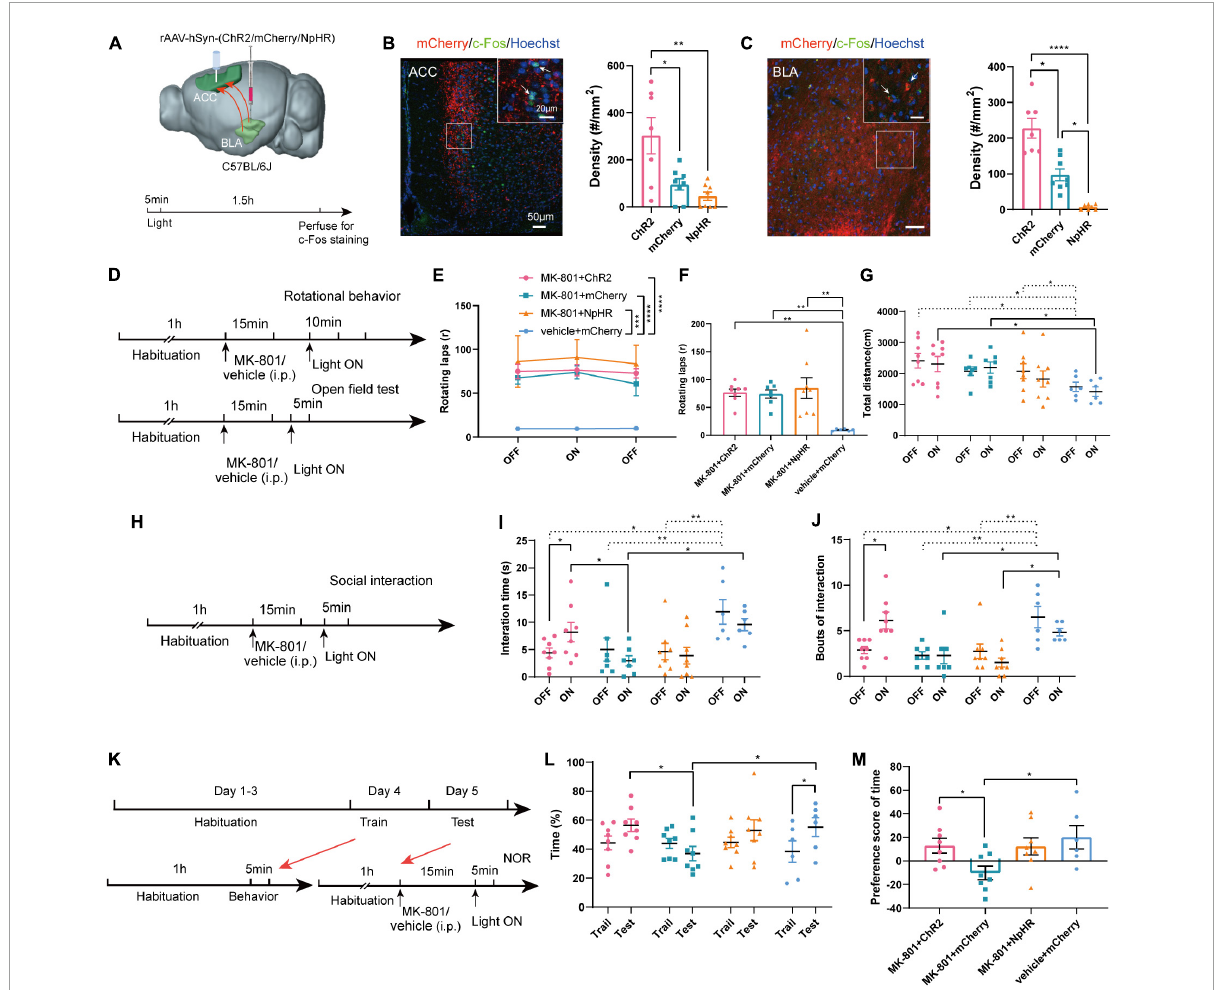
FIGURE5 Optogenetic modulation of basolateral amygdala-anterior cingulate cortex (BLA-ACC) projecting neurons affected social and cognitive deficits but not stereotypic rotational behavior in MK-801-treated mice. (A) Schematic of the mouse brain showing the bilateral injection of the rAAV2-hSyn-(ChR2/mCherry/NpHR)-WPRE-pA virus into the BLA and optical fibers implanted into the ACC of C57BL/6J mice. (B,C) The c-Fos-positive cells in the ACC [ (B) , Kruskal–Wallis H test, ChR2 n = 7 slices/4 mice, mCherry n = 8 slices/4 mice, NpHR n = 8 slices/4 mice] and BLA [ (C) , Kruskal–Wallis H test, ChR2 n = 7 slices/4 mice, mCherry n = 8 slices/4 mice, NpHR n = 7 slices/4 mice] after laser light on. (D) Timeline of optogenetic regulation of rotational behavior and OFT. (E–G) The results of the rotational behavior test [ (E) , Friedman’s M test; (F) , Kruskal–Wallis H test, MK-801 + ChR2 n = 8 mice, MK-801 + mCherry n = 7 mice, MK-801 + NpHR n = 8 mice, vehicle + mCherry n = 6 mice] and OFT [ (G) , One-factor ANOVA, MK-801 + ChR2 n = 8 mice, MK-801 + mCherry n = 7 mice, MK-801 + NpHR n = 8 mice, vehicle + mCherry n = 6 mice] after optogenetic regulation of BLA-ACC circuit. (H) Timeline of optogenetic regulation of social interaction behavior. (I,J) The results of the social interaction test (Kruskal–Wallis H test/One-factor ANOVA, MK-801 + ChR2 n = 8 mice, MK-801 + mCherry n = 7 mice, MK-801 + NpHR n = 8 mice, vehicle + mCherry n = 6 mice) after optogenetic regulation of BLA-ACC circuit. (K) Timeline of optogenetic regulation of NOR test. (L,M) The results of the percentage of time that mice spent in exploring the novel object [ (L) , One-factor ANOVA] and the preference scores of NOR test after optogenetic regulation of BLA-ACC circuit [ (M) , One-factor ANOVA, MK-801 + ChR2 n = 8 mice, MK-801 + mCherry n = 8 mice, MK-801 + NpHR n = 8 mice, vehicle + mCherry n = 6 mice]. Data are shown as the means ± SEM. *indicates a significant difference between groups. * p < 0.05, ** p < 0.01, *** p < 0.001, and **** p <